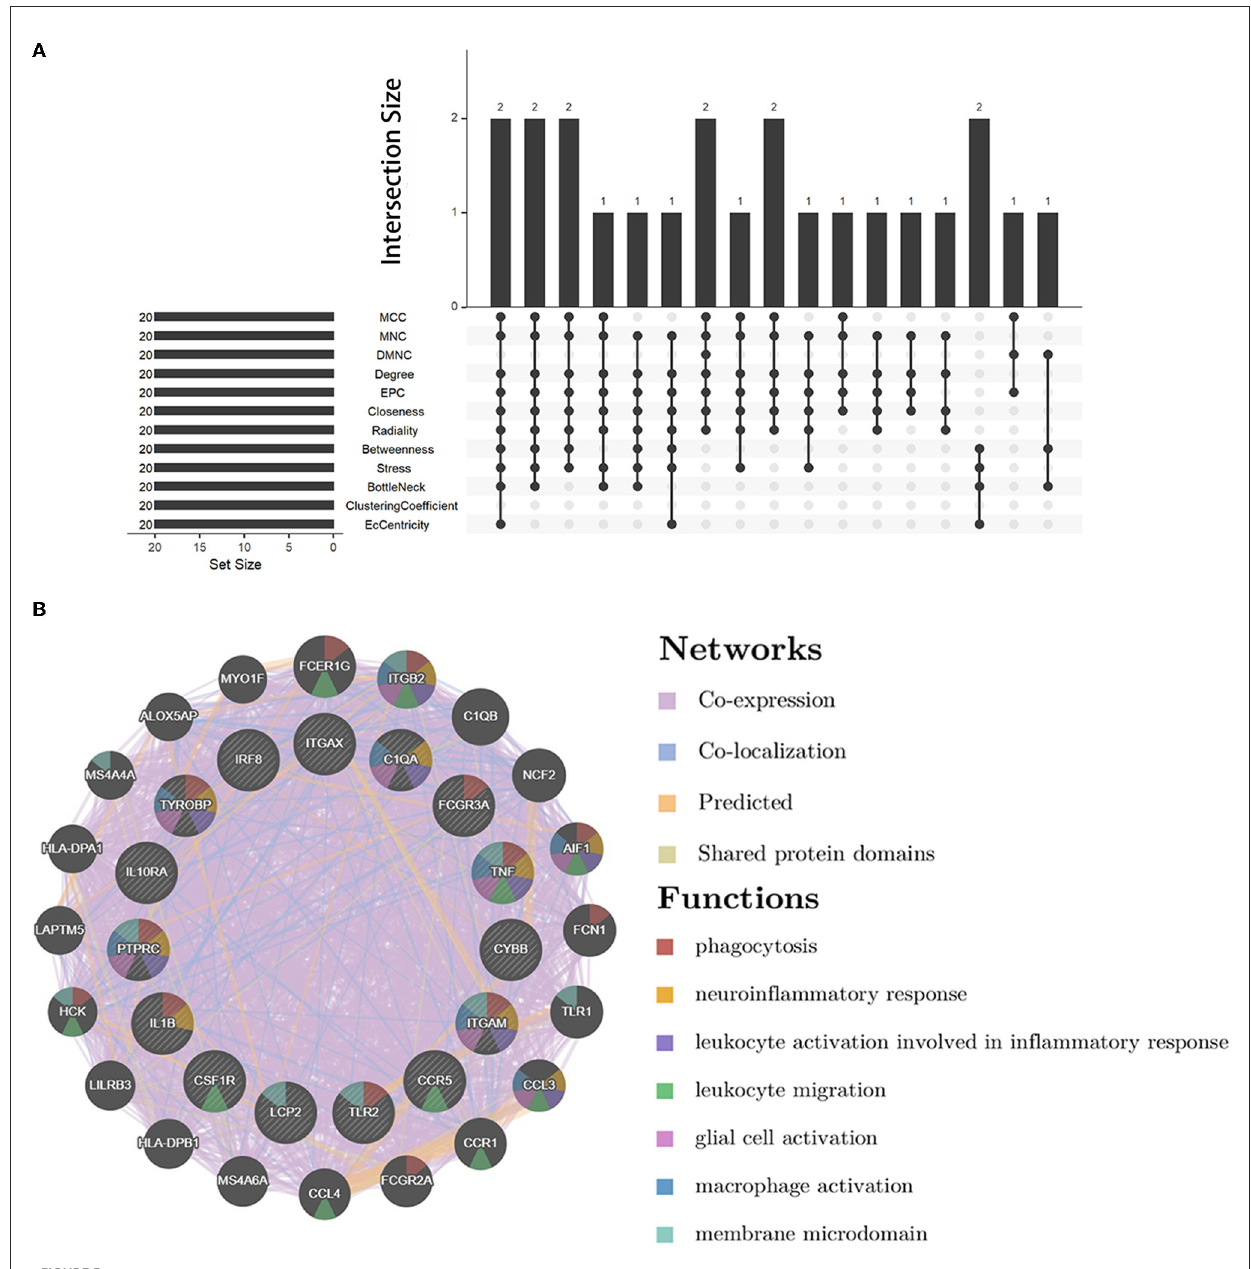
FIGURE5 Candidate hub gene co-expression network and upset plot. (A) The intersection of the top 20 genes within 12 methods of the cytoHubba module. (B) GeneMANIA was used to analyze candidate hub genes and associated co-expression